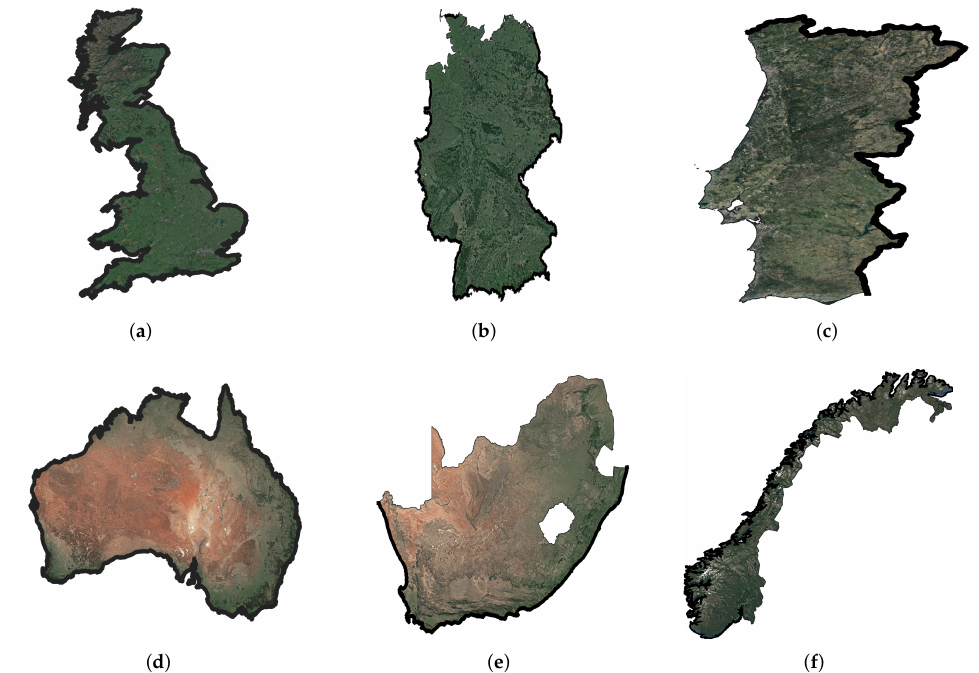
Figure 4. Some coastlines and borders. ( a ) Coastline of Great Britain, ( b ) Land frontier of Germany, ( c ) Land frontier of Portugal, ( d ) Coastline/border of Australia, ( e ) Coastline of South Africa, and ( f ) Coastline of